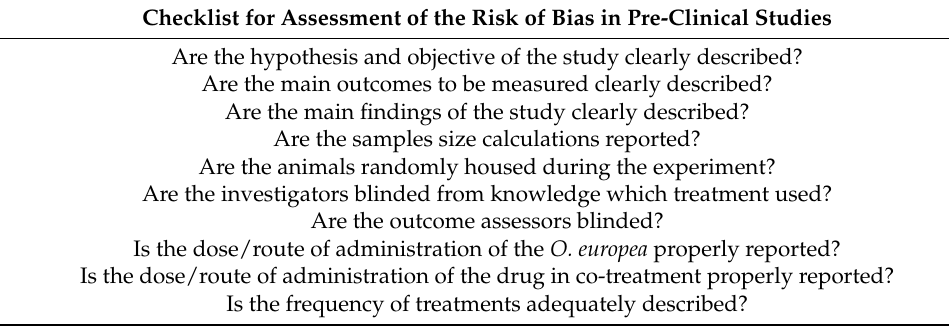
Table 6. Checklist for assessment of the risk of bias in clinical studies [127]. Checklist for Assessment of the Risk of Bias in Clinical Studies Are the hypothesis and objective of the study clearly described? Are the main outcomes to be measured clearly described? Are the main findings of the study clearly described? Are the samples size calculations reported? Are the subjects randomly housed during the experiment? Are the investigators blinded from knowledge which treatment used? Are the outcome assessors blinded? Is the dose/route of administration of the O. europea properly